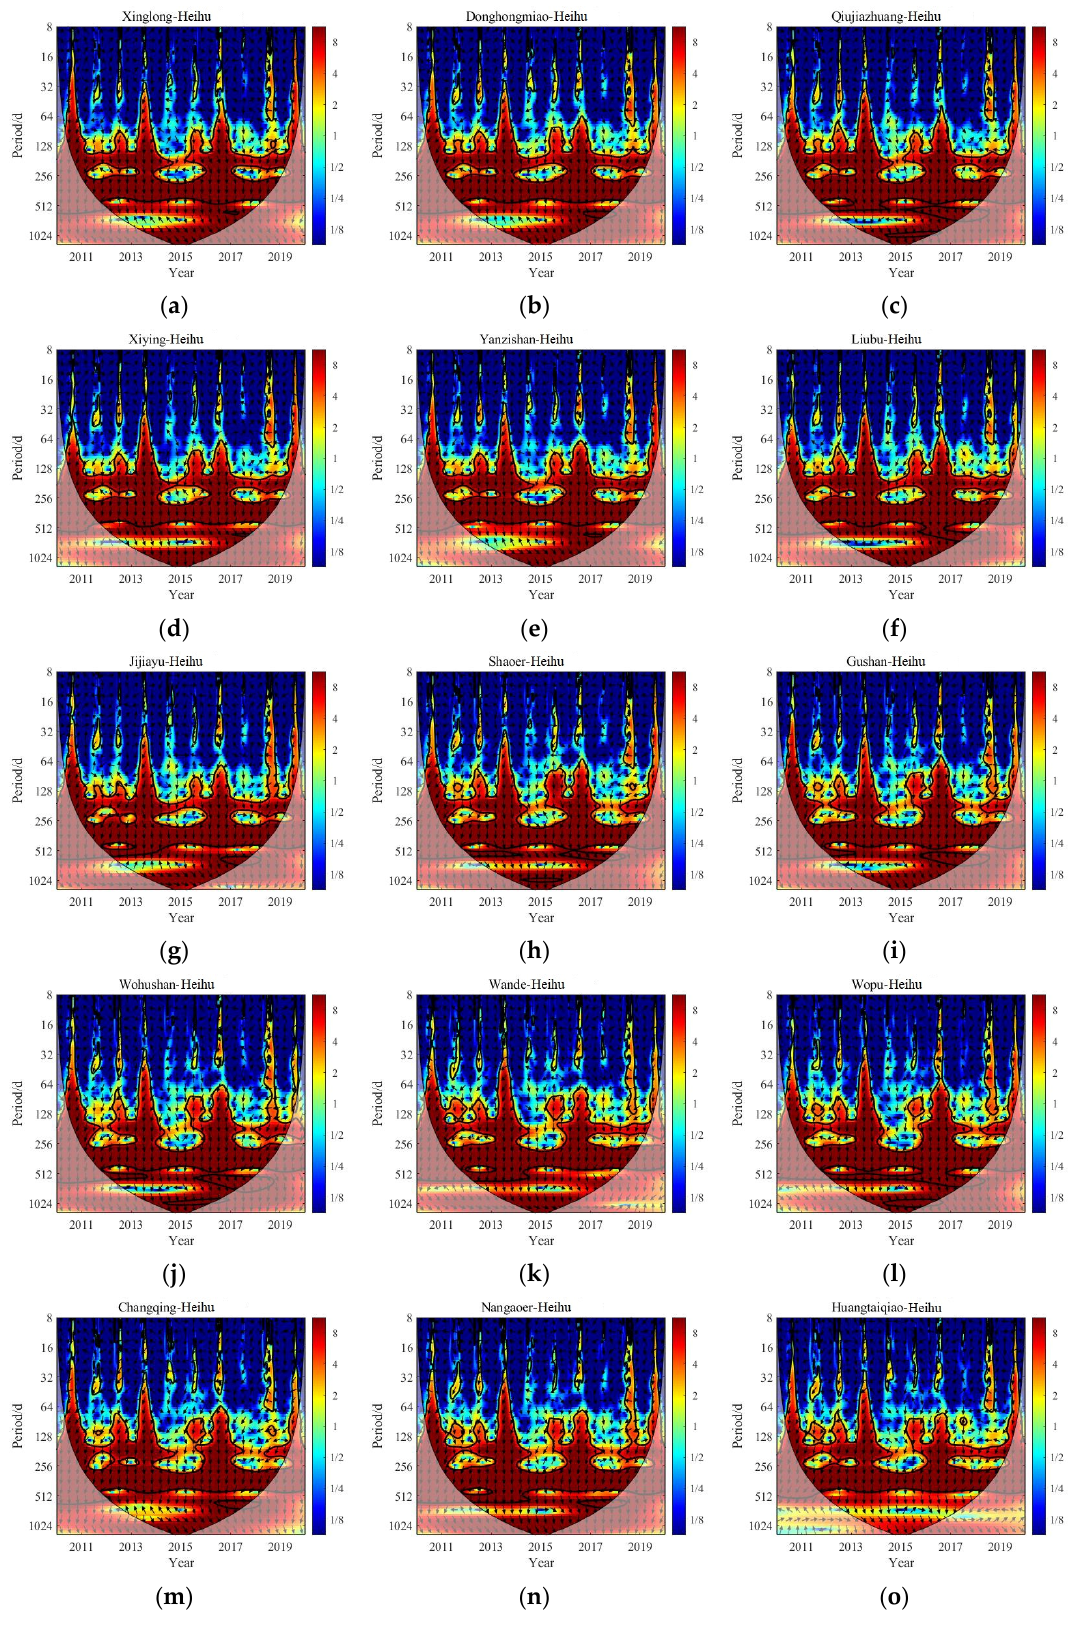
Figure 5. The XWTs of precipitation and HHS water level. ( a – o ) fifteen precipitation